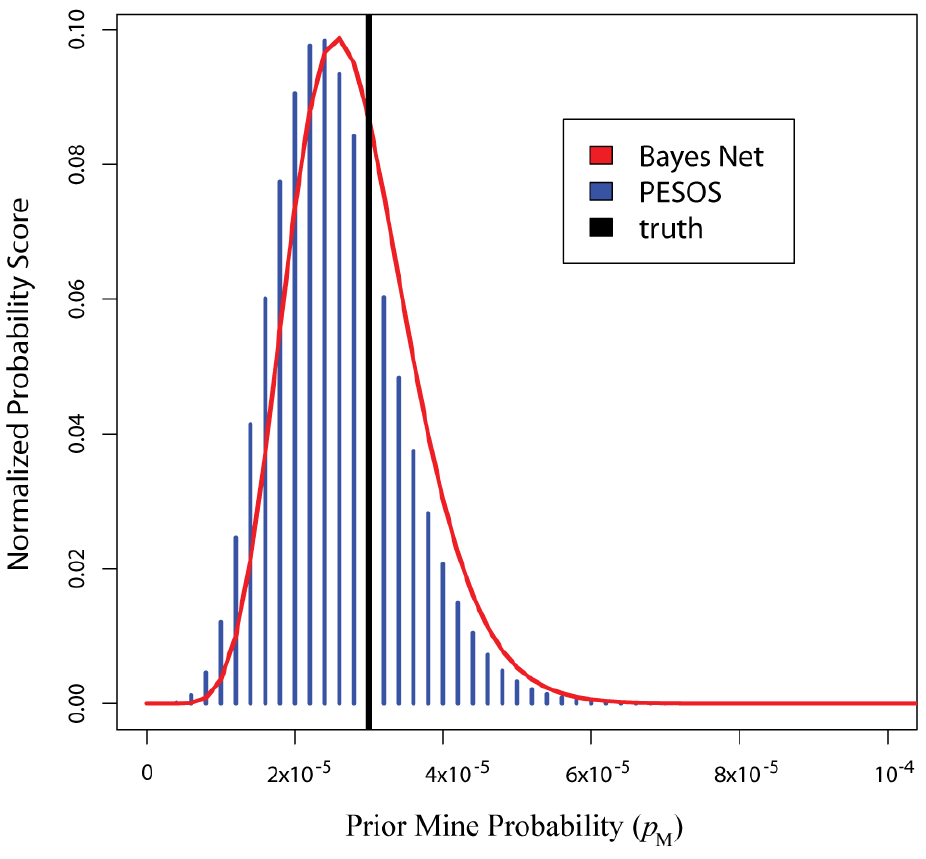
Figure 3. This figure gives the posterior scores computed over the 129 grid points of p M ( g ) using both the Bayes Net and PESOS approaches. These results were computed using the first simulated dataset.